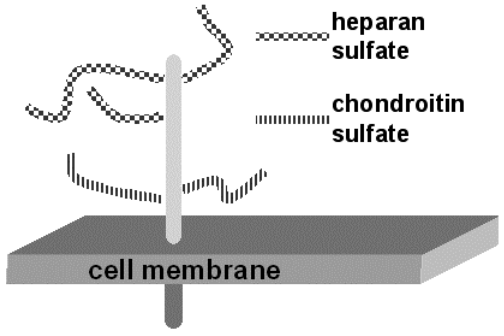
FIGURE 1. Diagrammatic representation of the structure of syndecan-1, a transmembrane HSPG with a comparatively short cytoplasmic domain and an ectodomain decorated with heparan sulfate and chondroitin